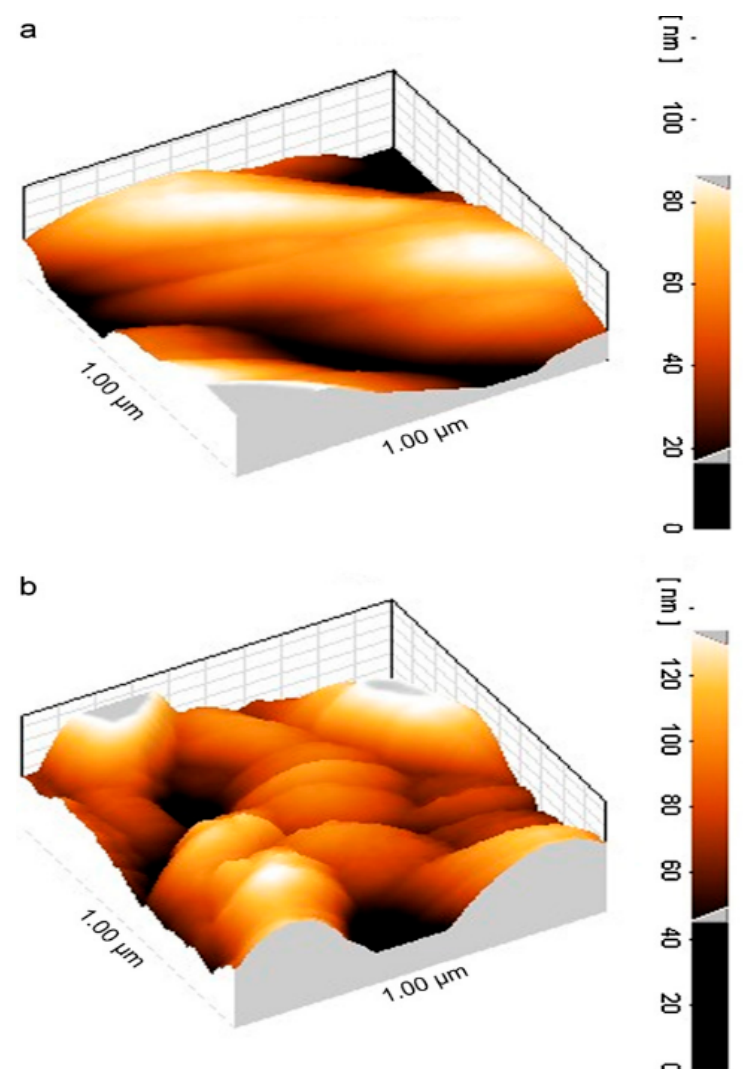
Figure 5. Three-dimensional AFM images of ( a ) aminated PAN-NF before adsorption and ( b ) after copper adsorption. Adapted with permission from reference [73].